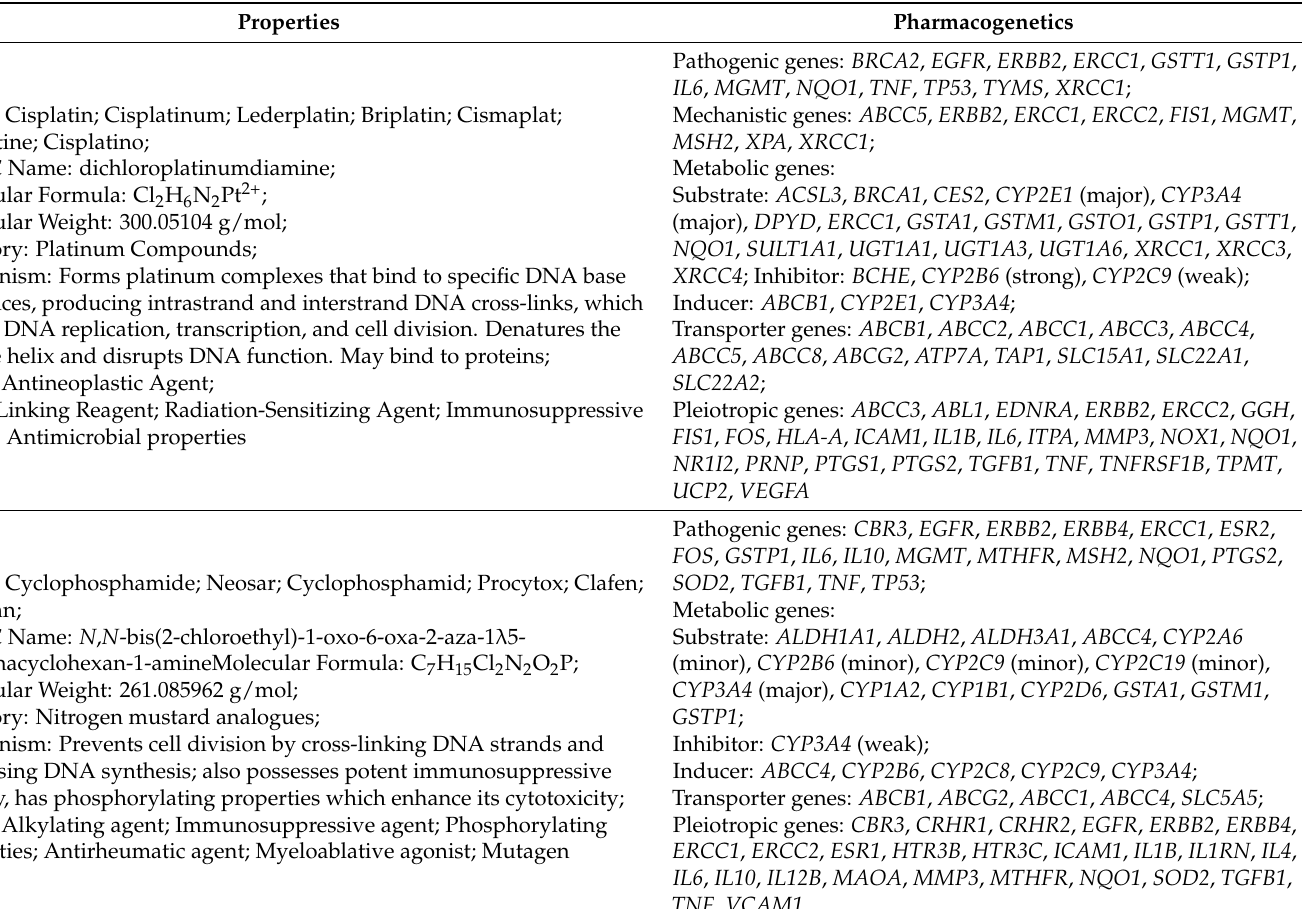
Table 4. Pharmacological properties and pharmacogenetics of selected antineoplastic agents.